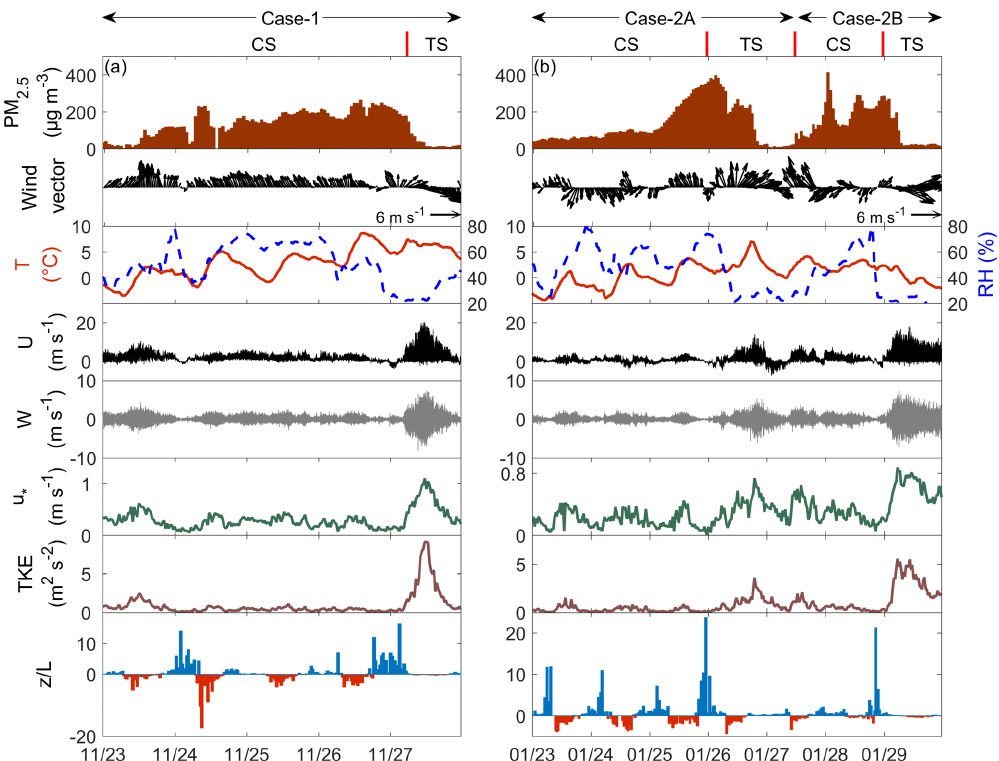
Figure 2. Time series of surface PM 2 . 5 , wind vector, temperature ( T ), relative humidity (RH), horizontal wind speed ( U ), vertical wind speed ( W ), friction velocity ( u ∗ ), turbulent kinetic energy (TKE), and stability parameter ( z/L ) for Case-1 in (a) and for Case-2 in (b) . The CS refers to the stage during which pollutants culminated, and the TS represents clear days. All of the variables were observed at 40m, except for PM 2 . 5 concentration which is at the